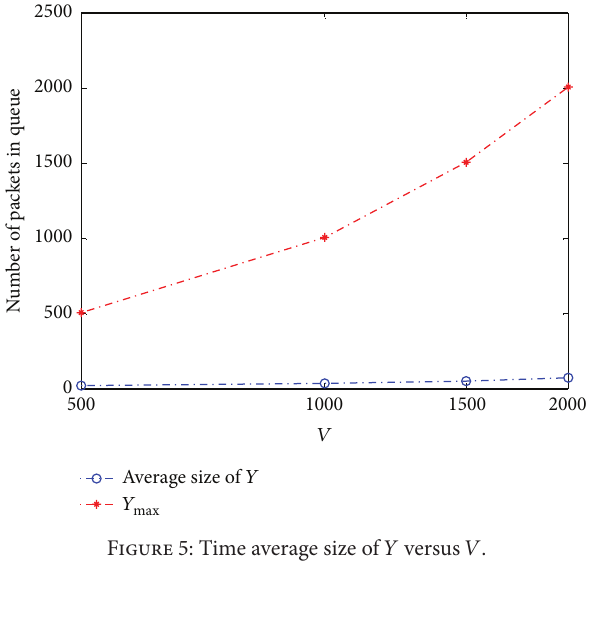
Figure 5: Time average size of 𝑌 versus 𝑉 .